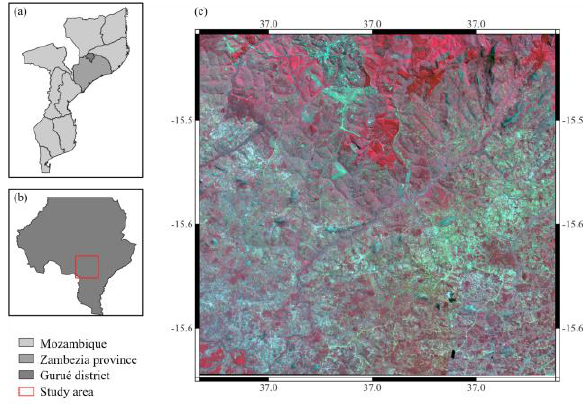
Figure 1 . Study area. (a) Mozambique country-level map, (b) Gurué district-level map, (c) PlanetScope imagery of study area false-color composite (R: near-infrared, G: red, B: